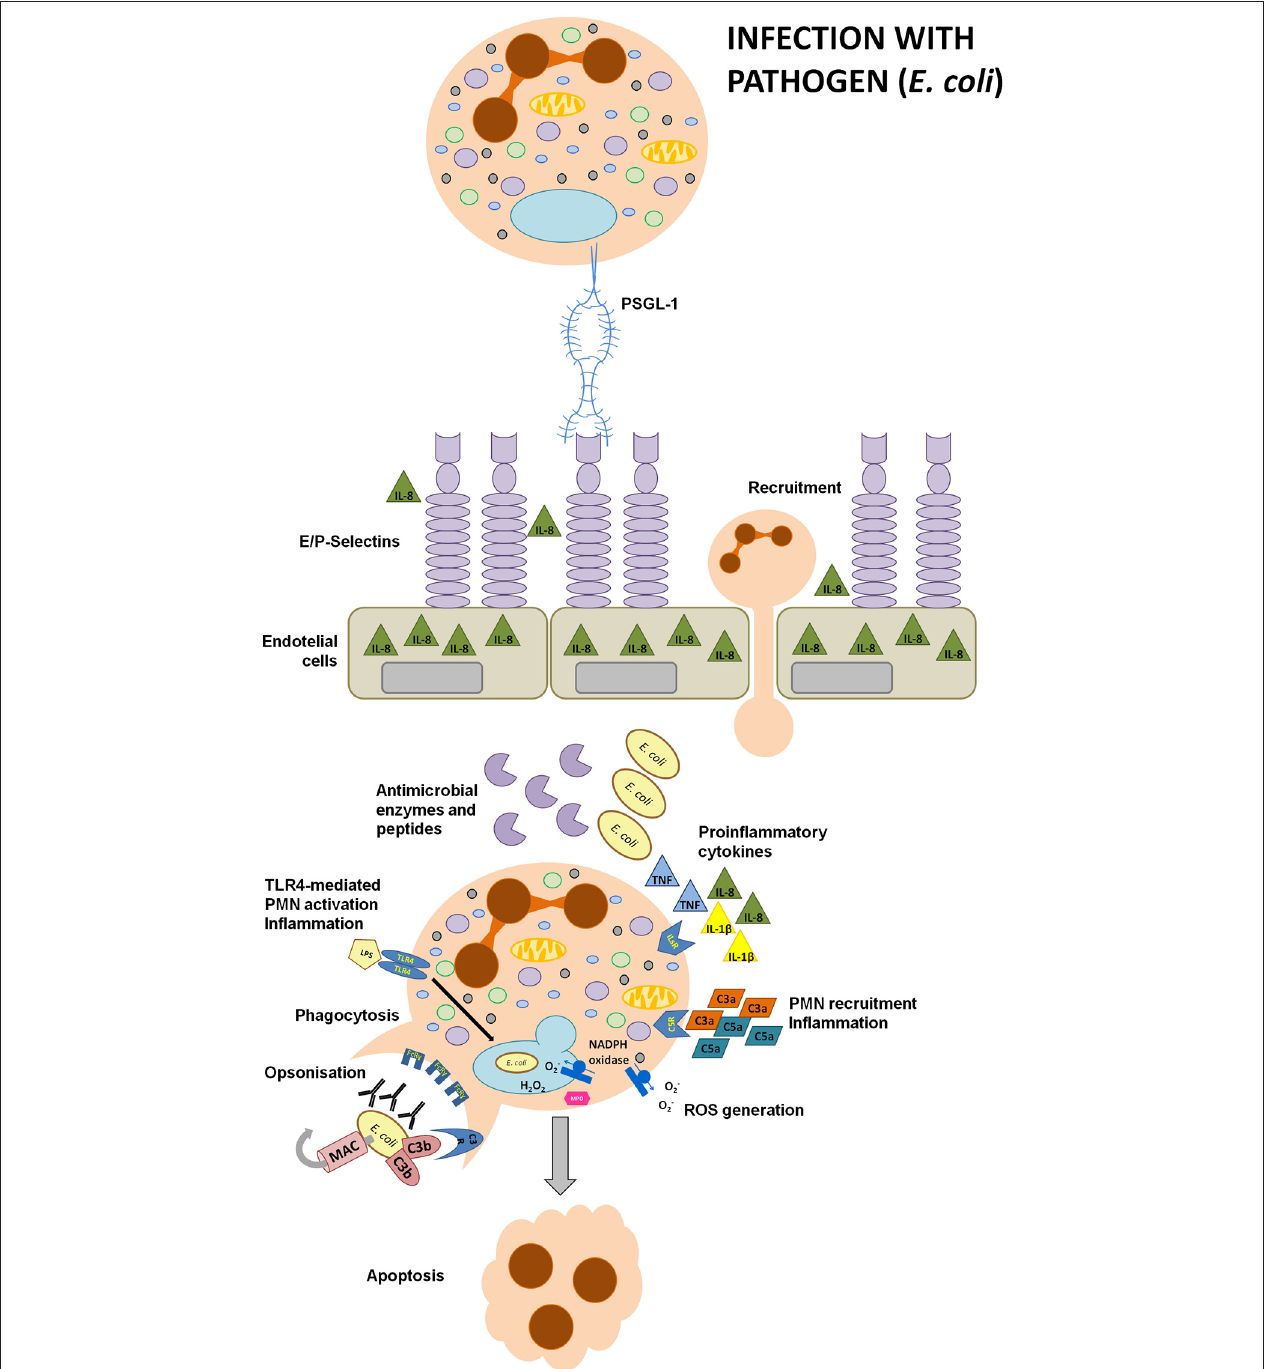
FIGURE 1 | Immune responses to pathogens. During an infection with pathogens, for example E. coli , lipopolisaccharide enhances the secretion of chemotactic IL-8 and stimulates the upregulation of E- or P-selectins expression on gingival endothelial cells (GECs). Selectins facilitate neutrophils adhesion during transmigration as they interact with PSGL-1 expressed on PMNs. Moreover, the presence of microbes and their particles activates the complement cascade. C3a and C5a are anaphylatoxins with a strong chemotactic and pro-inflammatory potential. IgG and IgM antibodies or C3b recognize bacterial antigens and opsonize invading pathogens thus facilitating bacterial phagocytosis. LPS activates the TLR4 signaling pathway in recruited neutrophils, eliciting strong inflammatory responses designed to inactivate the pathogen. Inflammatory responses include the production of reactive oxygen species, secretion of pro-inflammatory cytokines and antimicrobial enzymes or peptides, such as cathepsin G, elastase, cathelicidins or defensins. After a successful bacterial clearance, neutrophils undergo apoptosis, an essential process triggering the resolution of inflammation.